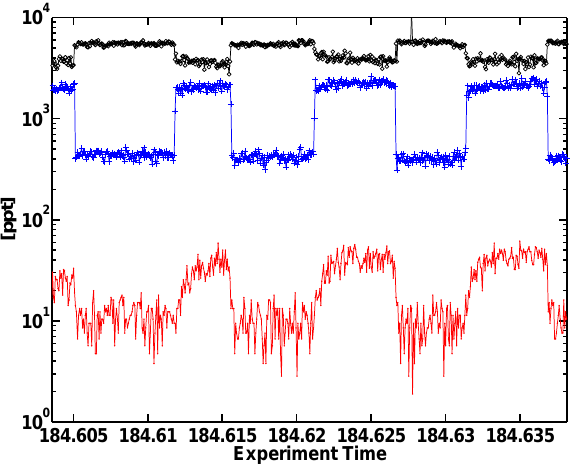
Fig. 3. The dependence of halogen products on the relative con- centration of chloride and bromide in the aqueous solution used to form the ice-coated flow tube. The error bars represent the 1 σ devi- ation of multiple determinations at each Cl:Br. The temperature of the ice surface was 258K, therefore precipitation effects are not ex- pected. Equal activation of ClNO 2 and Br 2 occurs at approximately 30:1 Cl:Br. The reaction of N2O5 with liquid water is inferred to be unimportant, consistent with the low mole fraction of H 2 O relative to the halides expected in the